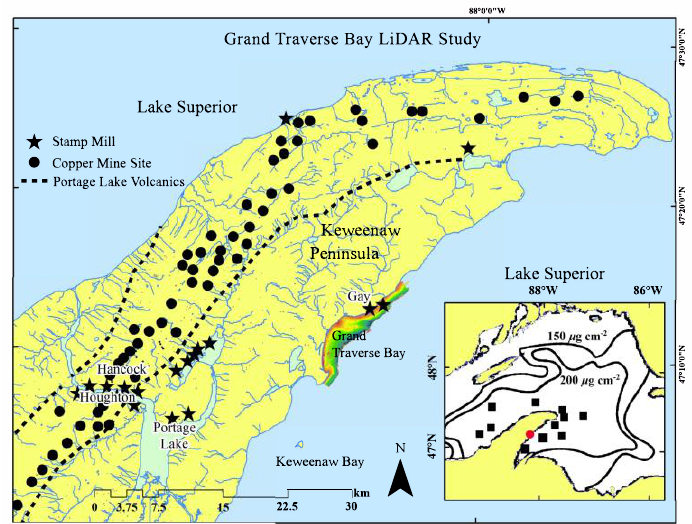
Figure 1. Geographic location of the Keweenaw Peninsula, Michigan., jutting out into Lake Superior. The position of Grand (Big) Traverse Bay is indicated along the eastern shore of the Keweenaw Peninsula, near Gay, by the red to green contours. On the Peninsula, copper mines are indicated by black dots, stamp mills by stars. Insert shows anthropogenic copper inventory “halo” around the Peninsula, in µg/cm 2 copper inventory (modified from [12]).